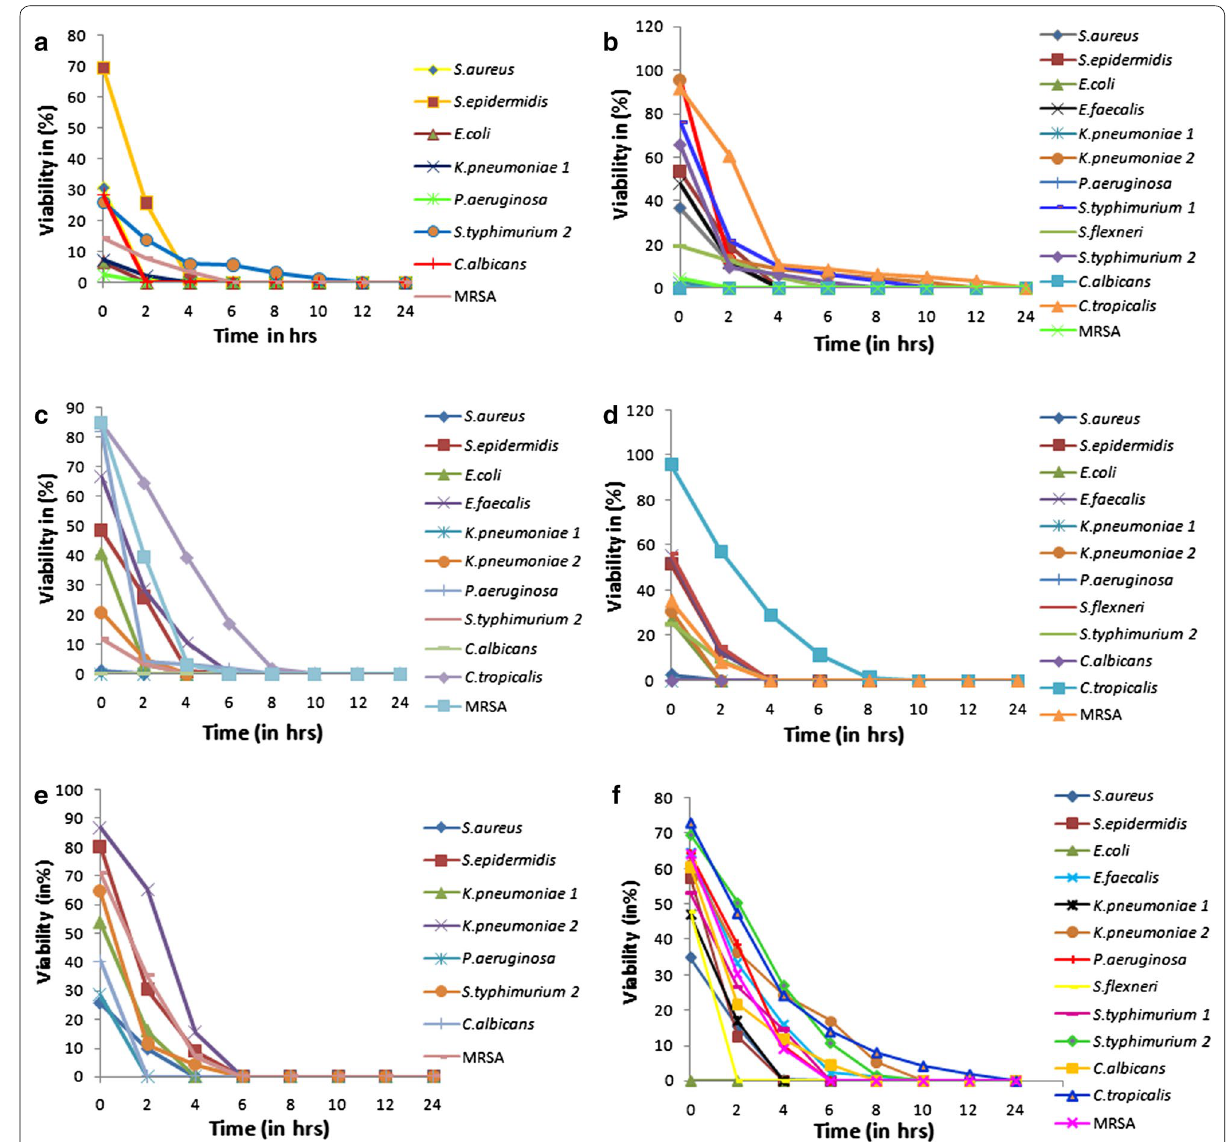
Fig. 2 Viable cell count (VCC) studies for ( a ) aqueous extract, ( b ) organic extract, ( c ) flavonoids, ( d ) diterpenes, ( e ) alkaloids of Berberis aristata root bark and ( f ) standard antibiotic Gentamicin (*Amphotericin B for yeast strains). SA, Staphylococcus aureus ; SE, Staphylococcus epidermidis ; EC, Escherichia coli ; KP1, Klebsiella pneumoniae 1; KP2, Klebsiella pneumoniae 2; SF, Shigella flexneri ; ST1, Salmonella typhimurium 1; ST2, Salmonella typhimurium 2; PA, Pseudomonas aeruginosa ; CA, Candida albicans ; CT, Candida tropicalis ; MRSA, methicillin-resistant Staphylococcus